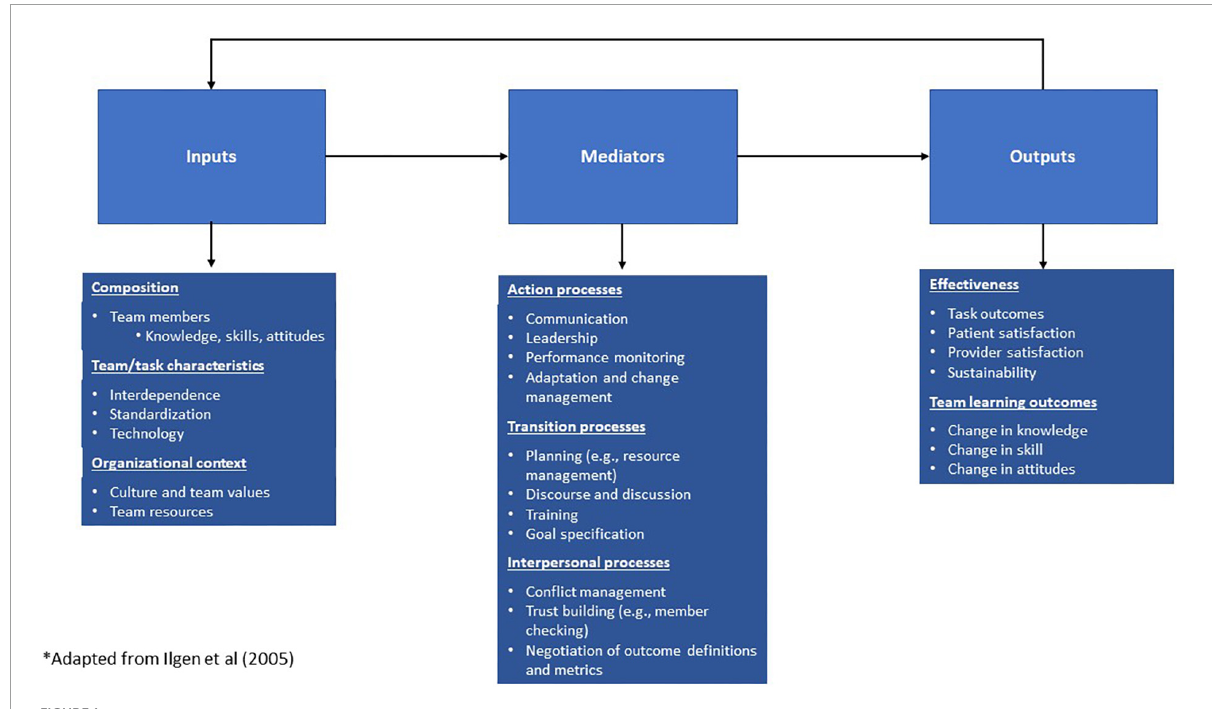
FIGURE1 Input-mediator-output-input framework for VCA team